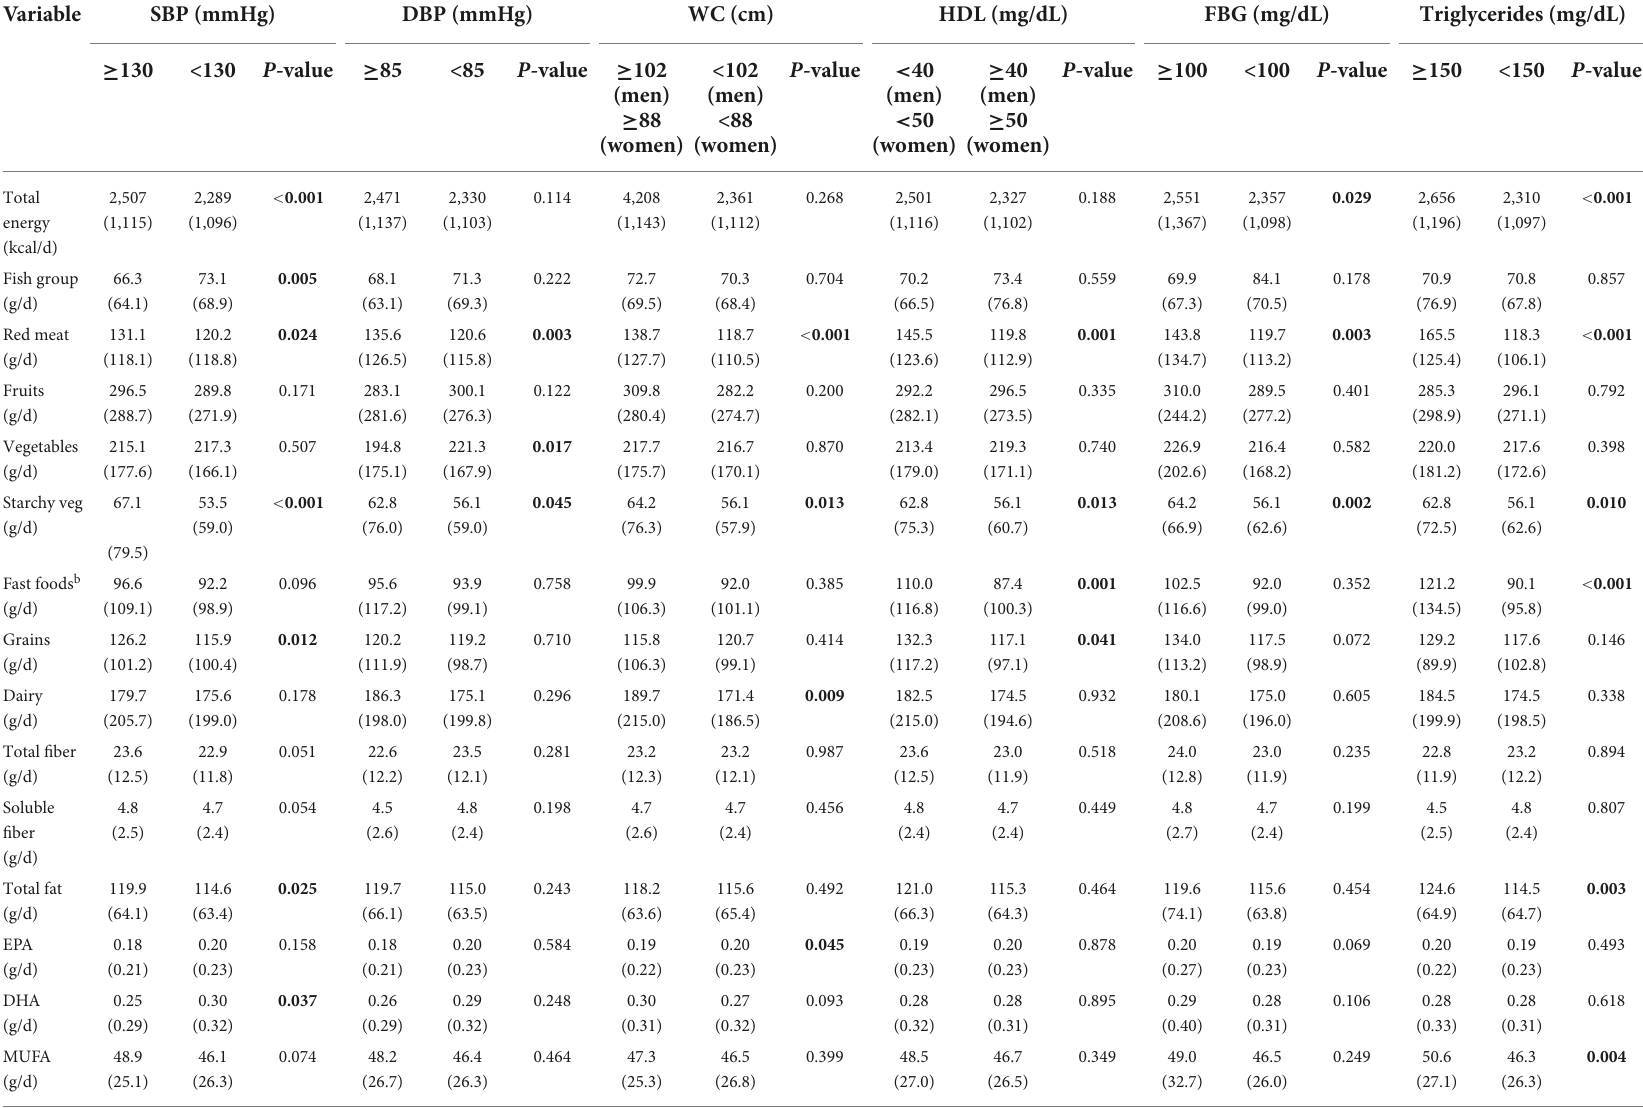
TABLE 3 Comparison (median and IR) of intake of food groups and selected nutrients based on MetS components. a